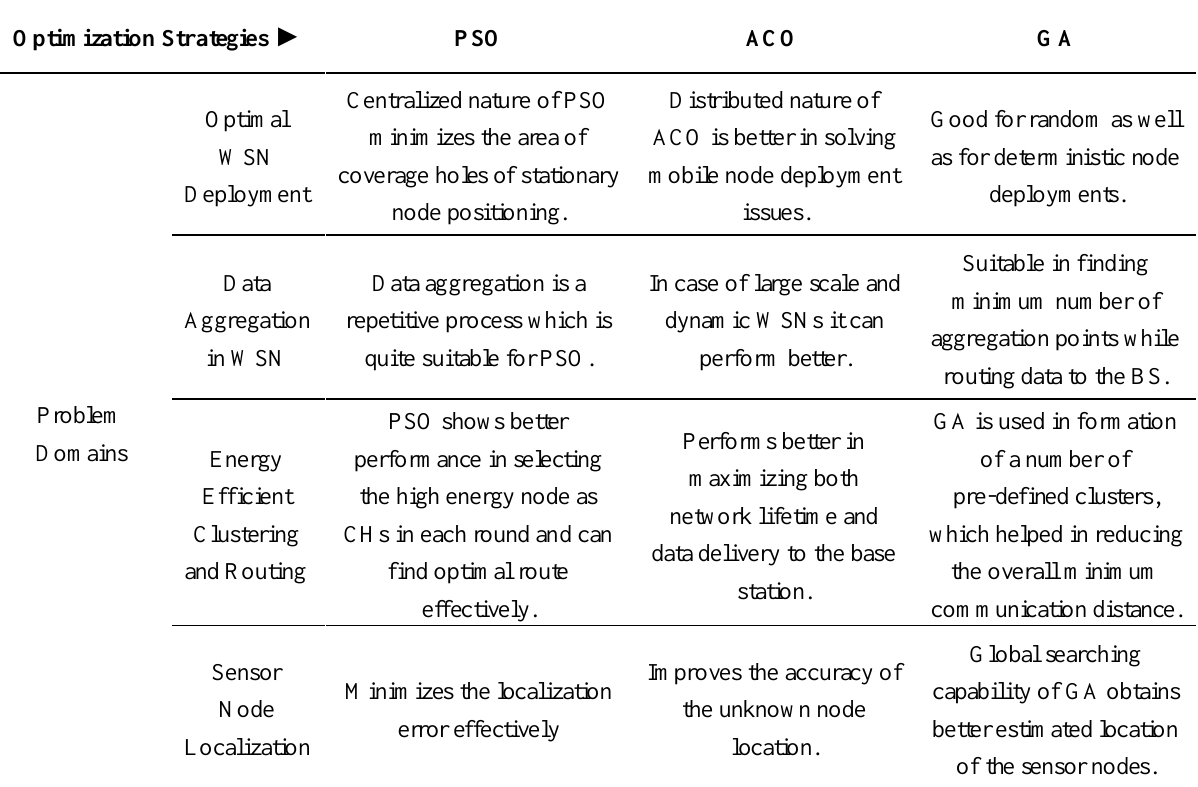
Table 4. Strengths of major bio-mimetic optimization algorithms in solving WSN problems. Optimization Strategies ►